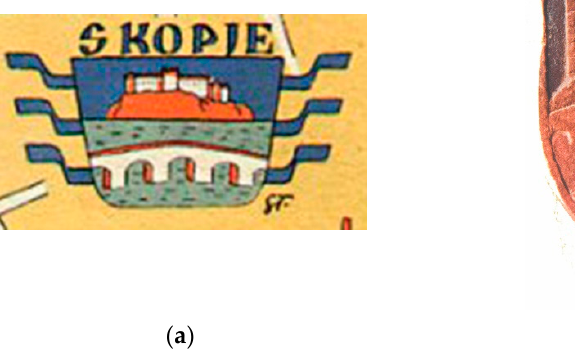
Figure 14. ( a ) Coat of arms of the City of Skopje (1950s); ( b ) Coat of arms of the City of Skopje (1965); ( c ) Coat of arms of the City of Skopje (1969).